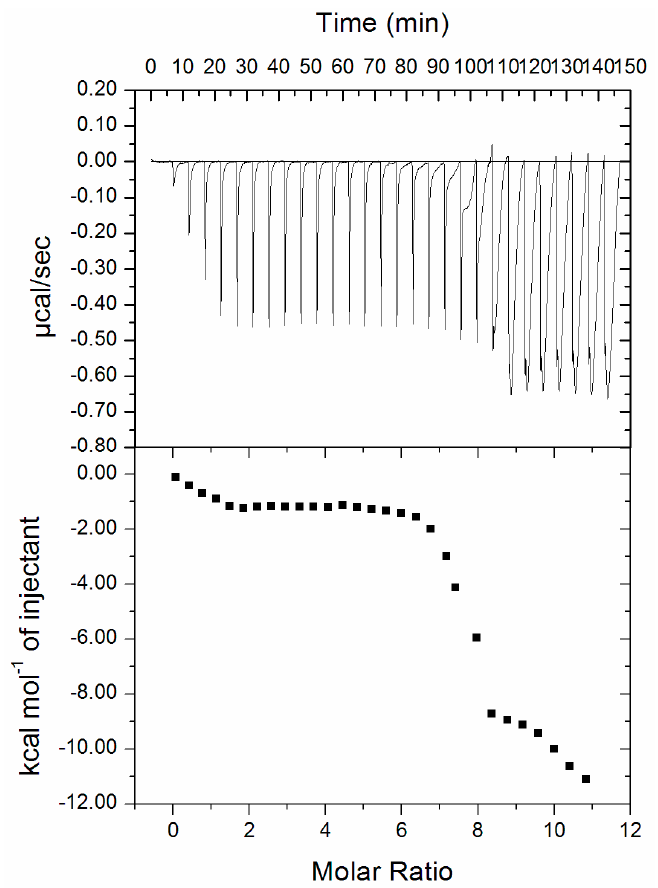
Figure 6. Isothermal titration calorimetry (ITC) profile of RT-hTf binding: Calorimetric responses owing to consecutive injections of RT in the ample cell with hTf are depicted in upper half whilst the lower panel shows integrated heats of interactions as a function of the [RT] / [hTf] molar